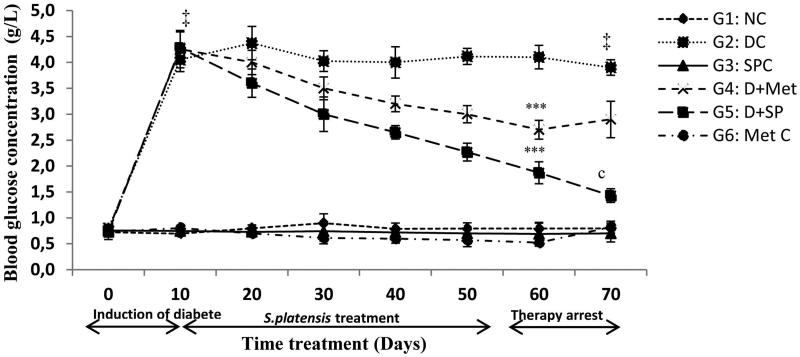
Effect of S. platensis administration on blood glucose level. NC: Normal Control; DC: Diabetic Control; SPC: SP control; D + Met: Diabetic rats treated with metformin; D + SP: Diabetic rats treated with SP; MetC: Metformin Control. Each value represents mean ± SE (n = 8). ‡p < 0.001, compared with group 1 values, ***p < 0.001, compared with group 2 values, (c) p < 0.001, compared the same group before and after therapy arrest (60th and 70th day) values.